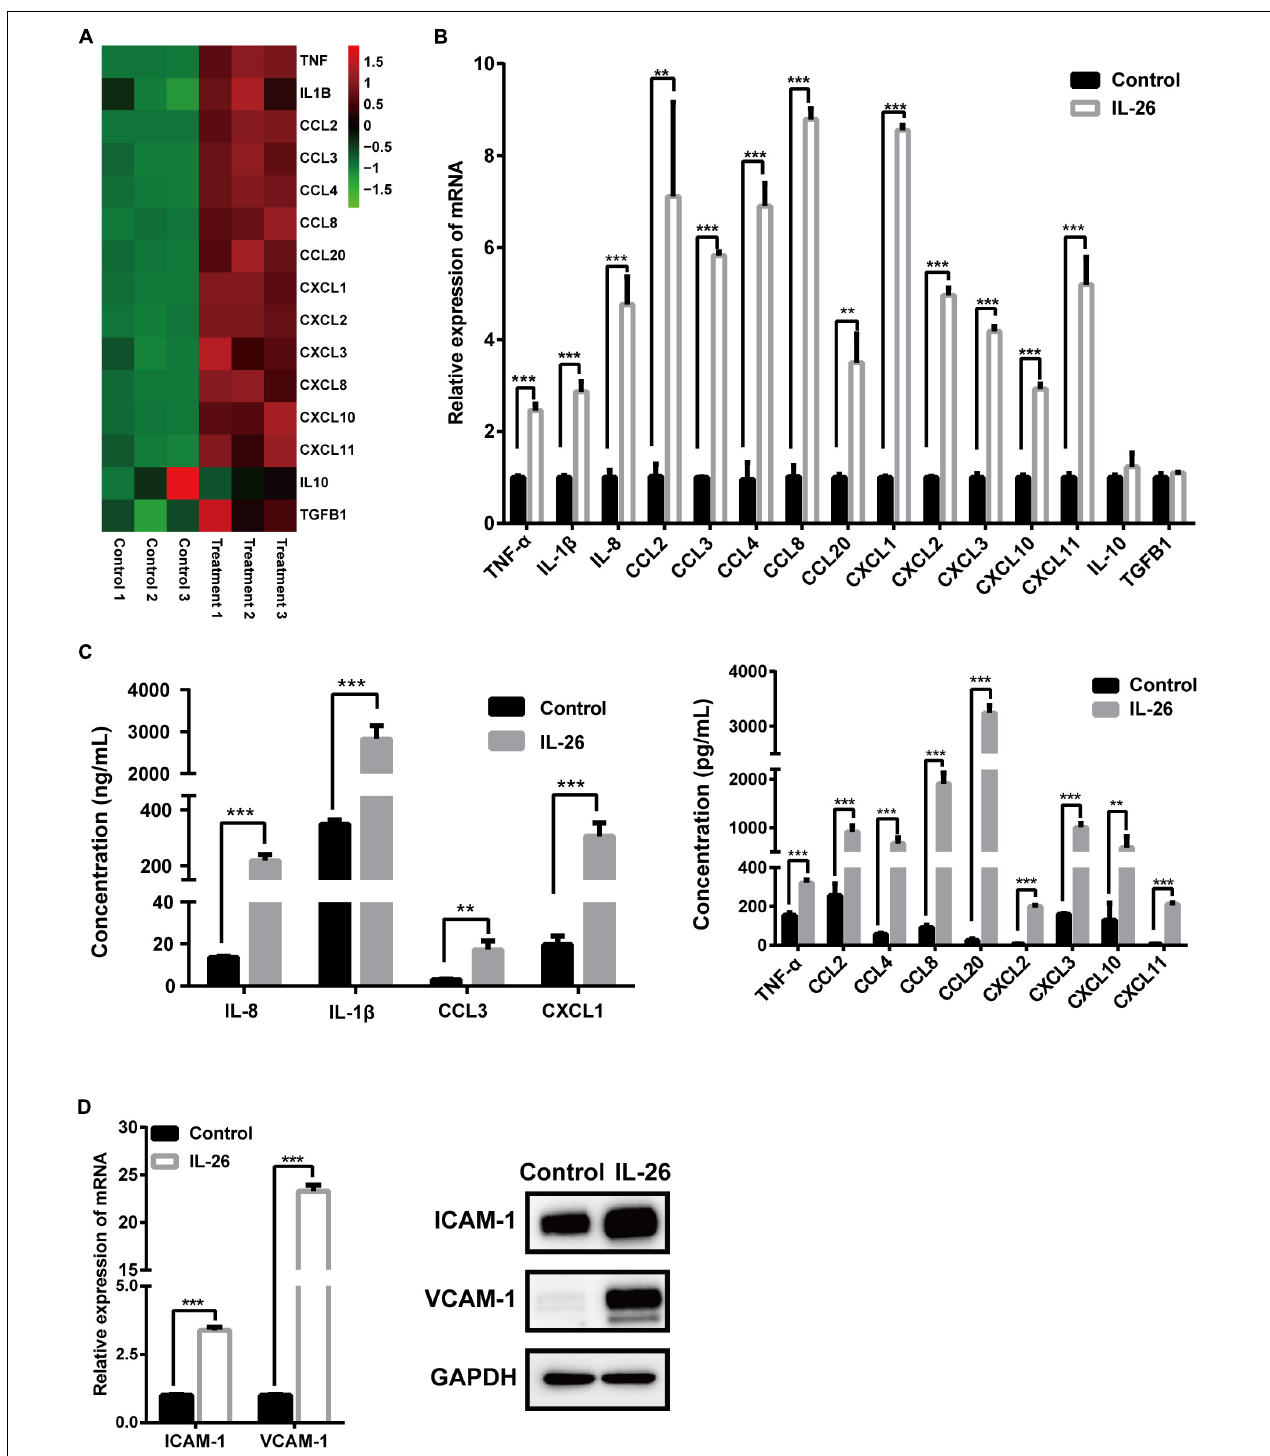
FIGURE 5 | Effect of IL-26 exposure on mRNA and protein levels of cytokines, chemokines and adhesion molecules in THP-1 macrophages. (A) Heatmap of 15 immune- or inflammation-related genes. (B) mRNA levels of several cytokines and chemokines in THP-1 macrophages treated with IL-26. (C) Protein levels of several cytokines and chemokines in the supernatants from THP-1 macrophages exposed to IL-26. (D) mRNA and protein levels of ICAM-1 and VCAM-1 in THP-1 macrophages exposed to IL-26. Gene expression results were changed to Data are expressed as mean ± SD and are representative of three independent biological replicates. Images are representative of two independent biological replicates. ** P < 0.01, *** P < 0.001.